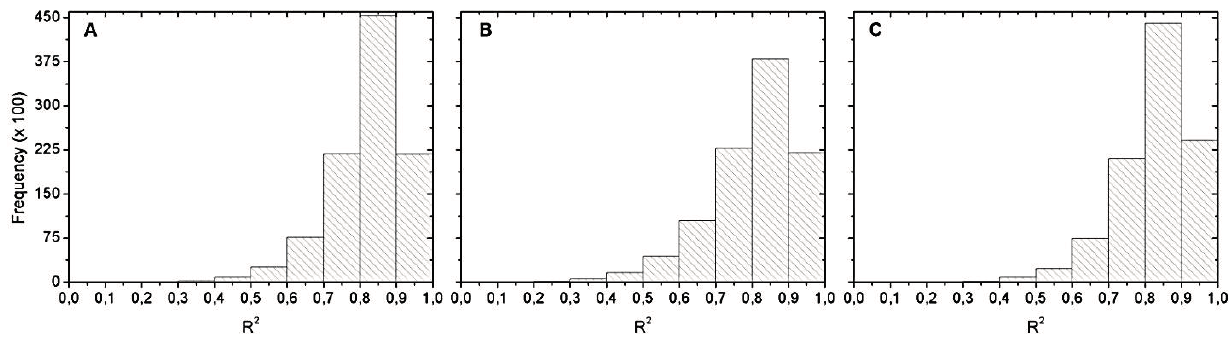
Figure 8. Histograms of the R 2 distribution for: ( A ) May 2012; ( B ) September 2012 and ( C ) April 2013. All hyperspectral data.